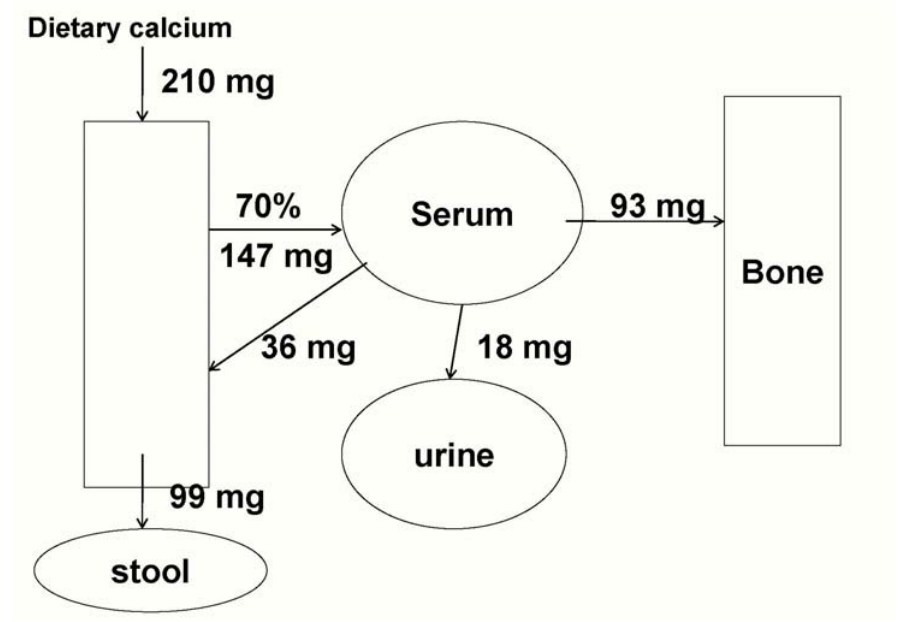
Figure 1. Calcium balance in a typical 6 kg exclusively breast-fed infant. Net calcium retention of 93 mg/day is shown as going to